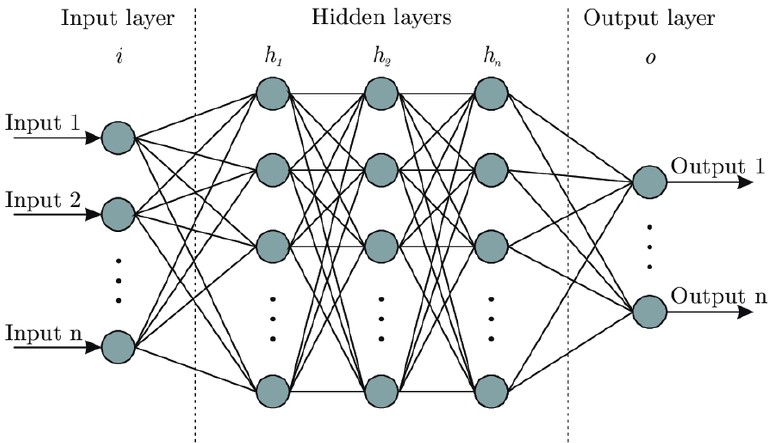
Figure 2. Architecture of an artificial neural network (MLP) [30] .